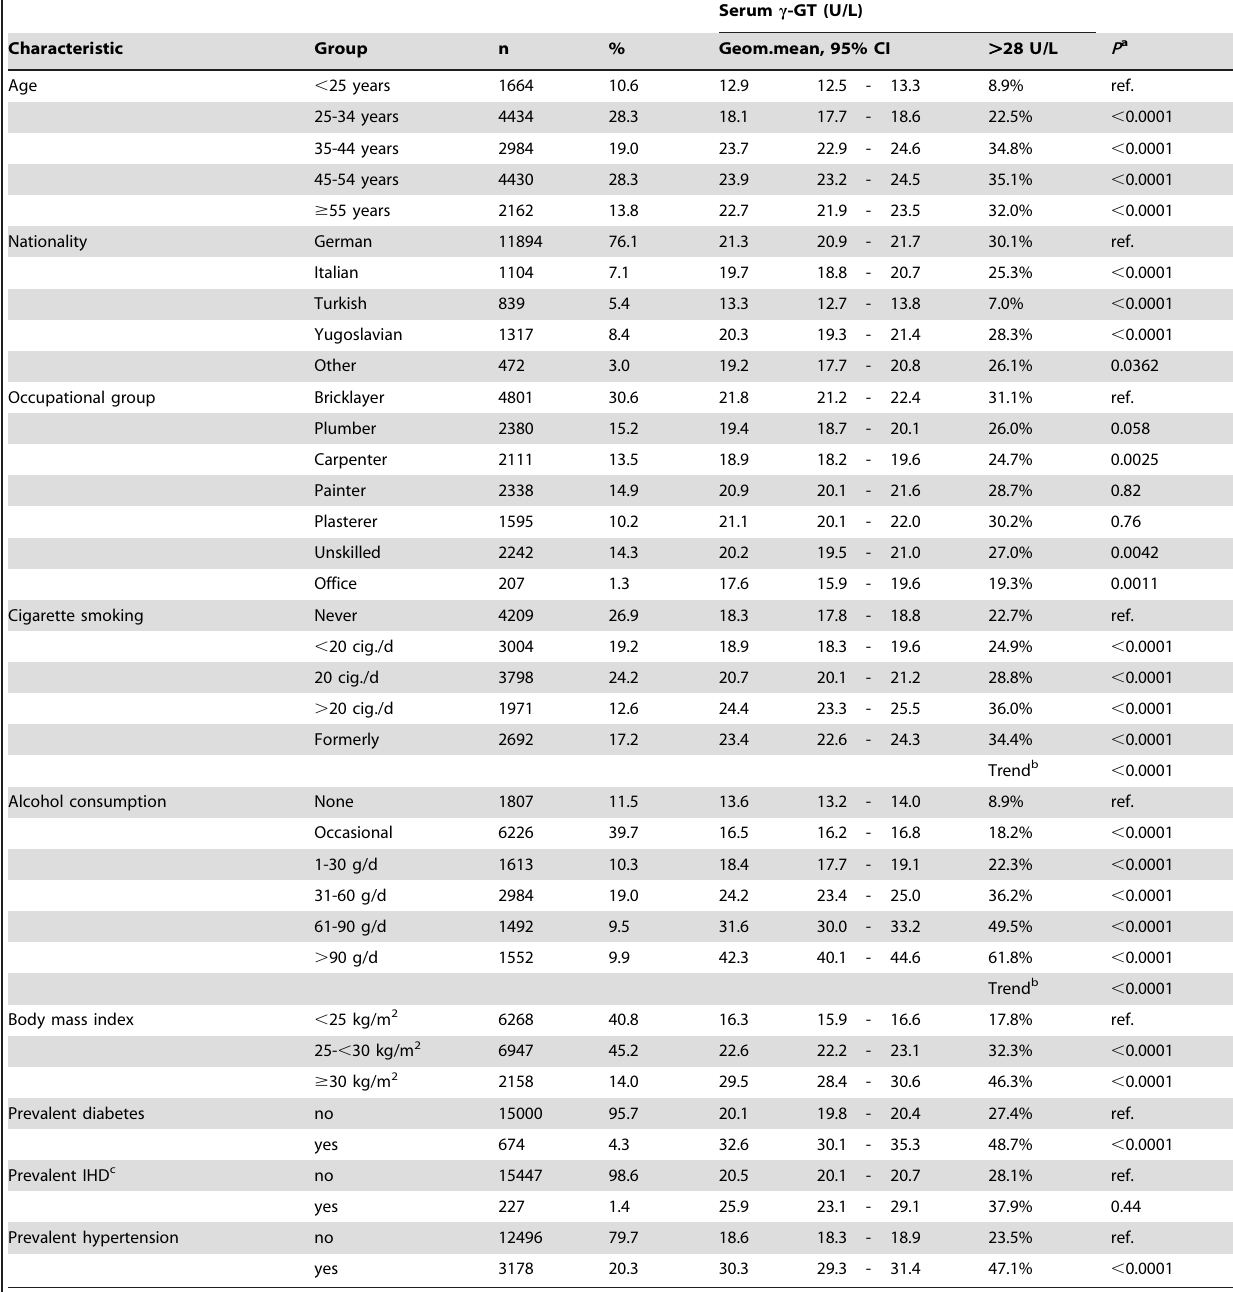
Table 1. Description of study